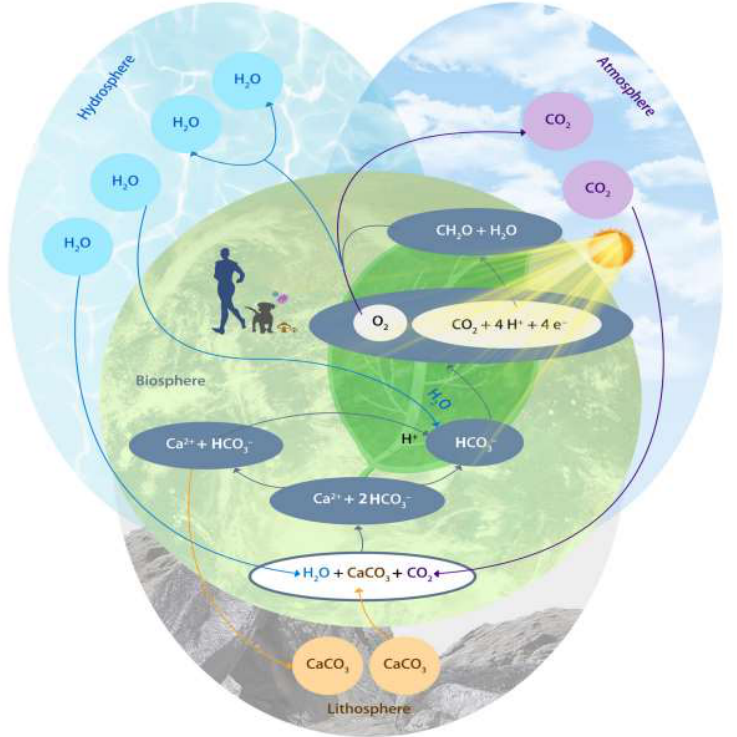
Figure 2. Karstification–photosynthesis coupling processes and their role in the water–carbon balance in nature (Yanyou Wu